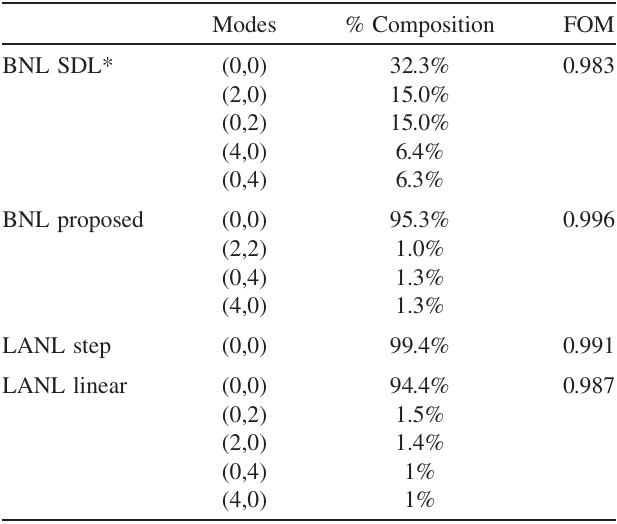
TABLE II. Modal composition as found by minimizing the coefficient area of the optical mode captured at the undulator exit. Cross-correlation value is reported as the figure of merit (FOM). (* used 14 (cid:3) 14 ¼ 196 modes to perform decomposi-